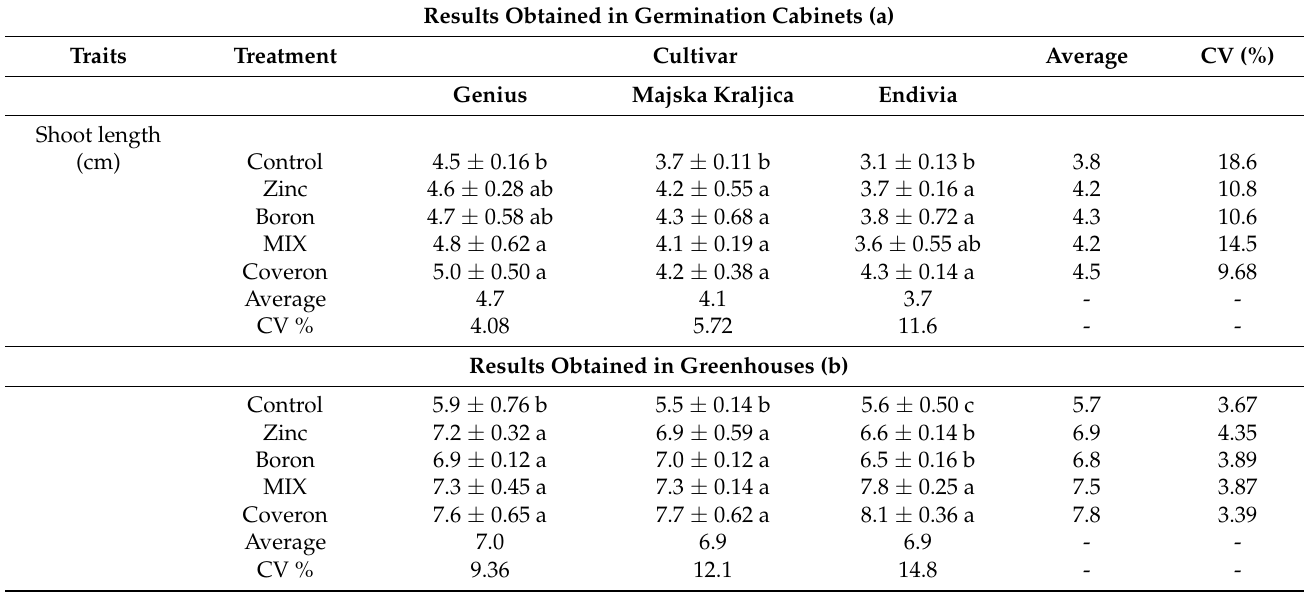
Table 2. Growth of shoot length after treatments applied to lettuce cultivars.